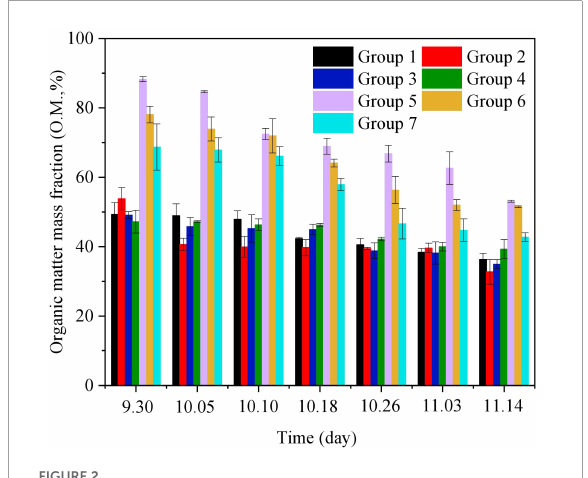
FIGURE2 Changes of organic matter mass fraction during the aerobic composting progress. The brief description of the symbols in the figures were similar with Figure 1